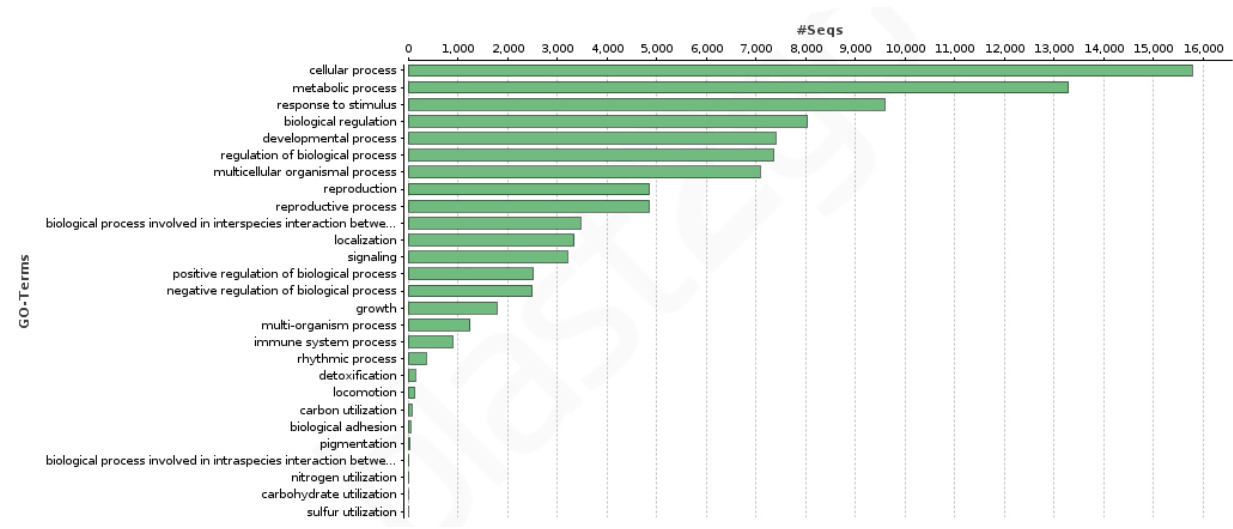
Figure 2. Distribution of the GO terms in the second GO hierarchical level for the biological process category.